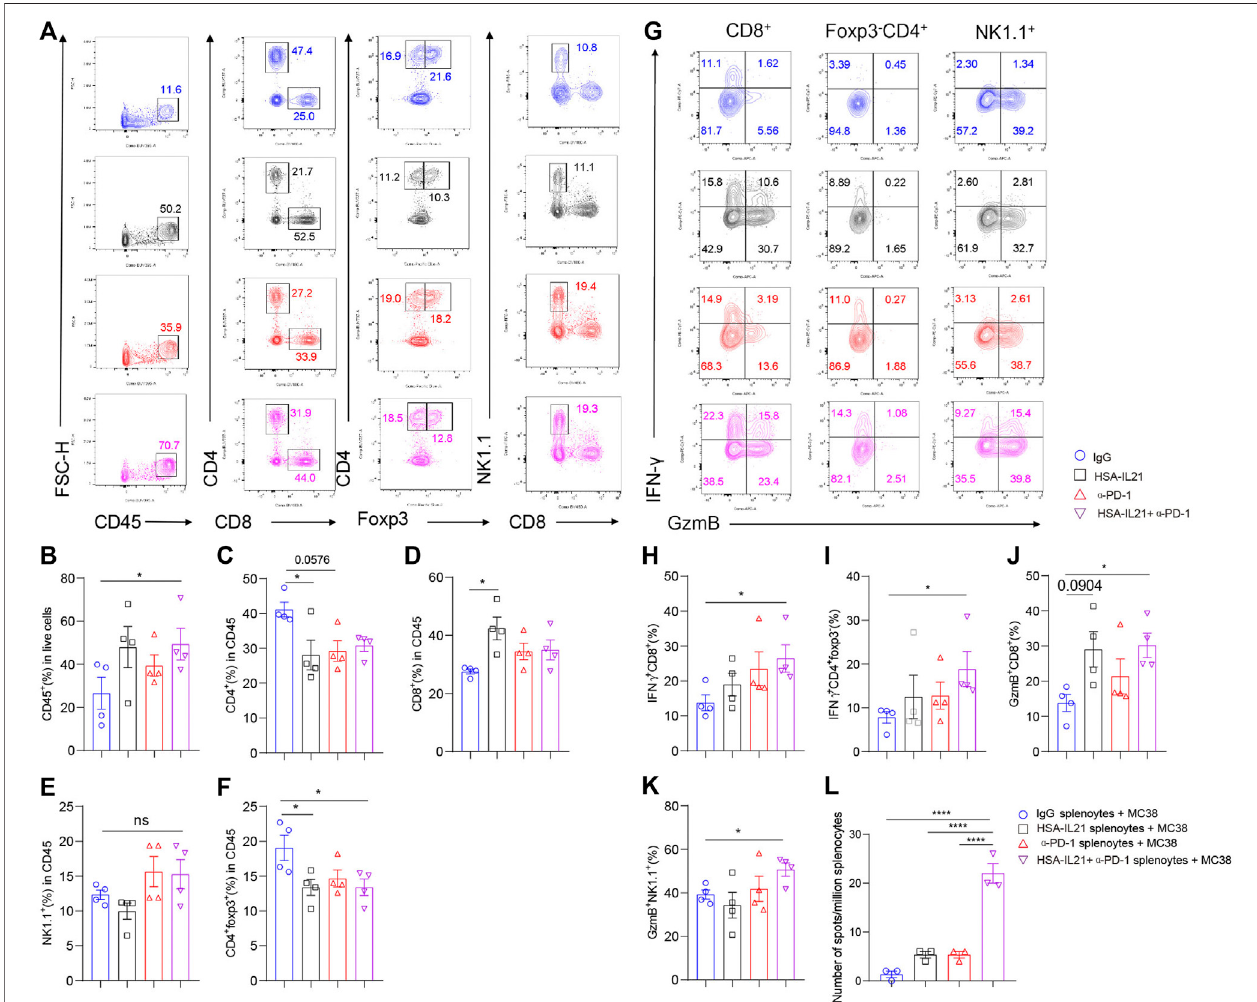
FIGURE7| Combinationtherapysustainsanti-tumorimmuneresponsesinTMEandperiphery. (A – L) MC38tumorcells(1 × 10 6 )wereinjectedintradermallytoB6 mice, 5 days after tumor inoculation, MC38 tumor-bearing mice were treated with IgG, HSA-IL21, α -PD-1, HSA-IL21/ α -PD-1 for total 4 times, after last treatment 48h, tumors were resected and analyzed by fl ow cytometry ( n (cid:2) 4). (A) Representative fl ow plots showing the percentage of main immune populations. (B – F) Quantitative percentageoftumor in fi ltrating CD45 + lymphocytes, percentagesofCD8 + ,CD4 + , Foxp3 - CD4 + ,Foxp3 + CD4 + Tcells and NKcells. Datawere presented asmean ± SEM, n (cid:2) 4, *p < 0.05, ** p < 0.01, *** p < 0.001, **** p < 0.0001,one-wayANOVA test wasperformed. (G) Representative fl ow plotsshowing IFN- γ and GzmB stainingin CD8 + , Foxp3 - CD4 + T cells and NK cells. (H – K) Quantitative percentage of IFN- γ and GzmB expression in CD8 + , Foxp3 - CD4 + T cells and NK cells. Data were presented asmean ± SEM,n (cid:2) 4, *p < 0.05,** p < 0.01,*** p < 0.001,**** p < 0.0001,one-wayANOVAtestwereperformed. (L) Numbersoftumor-antigenspeci fi cIFN- γ producers in the splenocytes. Data were presented as mean ± SEM, n (cid:2) 3, *p < 0.05, ** p < 0.01, *** p < 0.001, **** p < 0.0001, one-way ANOVA test was performed.